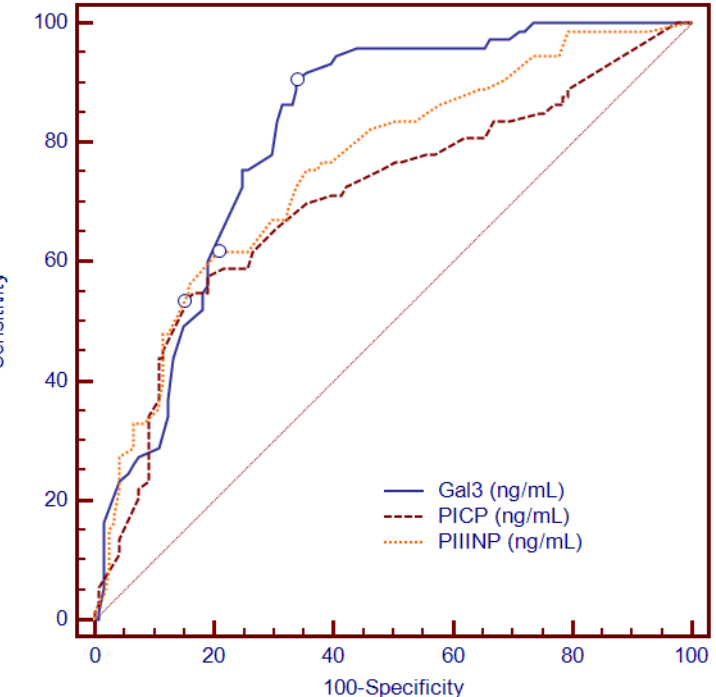
Figure 2. ROC analysis demonstrating the ability of Gal-3, PICP and PIIINP to identify the presence of LGE. Abbreviations: Gal-3, galectin-3; LGE, late gadolinium enhancement; PICP, procollagen type I carboxy-terminal pro-peptide; PIIINP, N-terminal pro-peptide of procollagen type III; ROC, receiver operating characteristics.